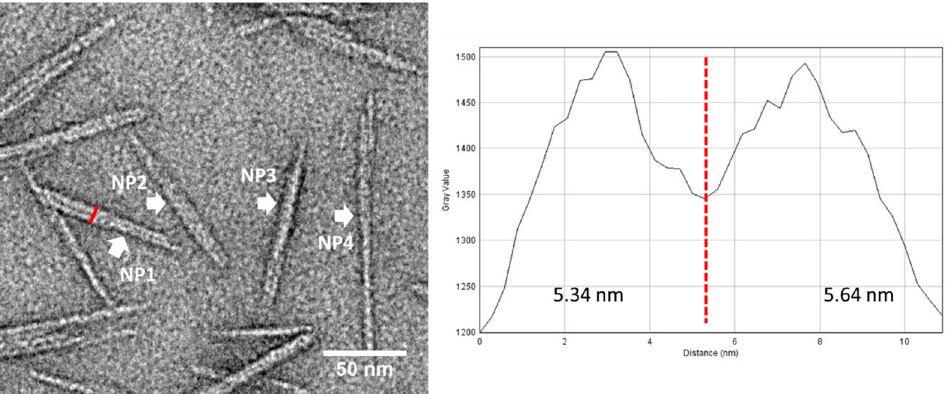
Figure 7. Right : Aggregated CNCs with different orientations marked by arrows (NP1, NP2, NP3 & NP4) on carbon film supported TEM grids. Left : The line profile of NP1 composed of two laterally jointed CNCs with width of 5.34 nm and 5.64 nm, respectively.